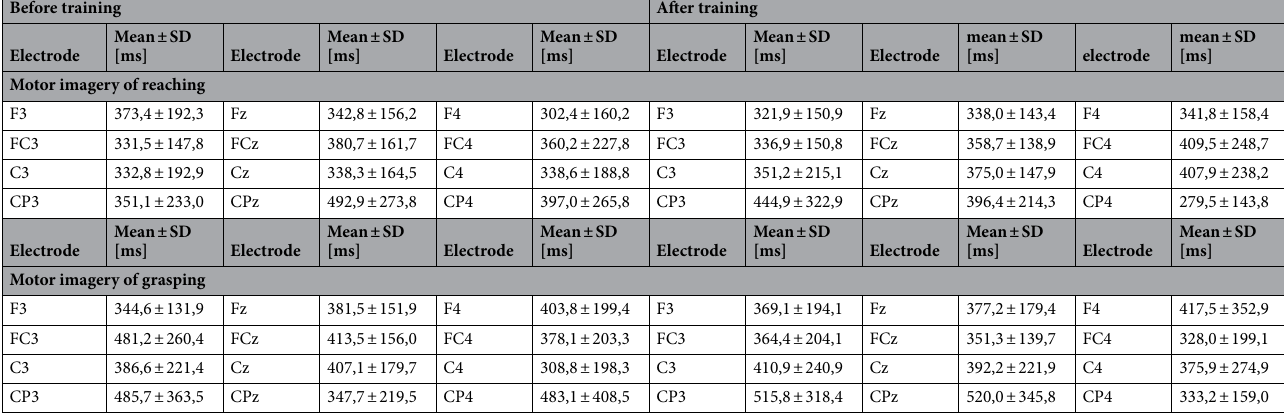
Table 4. Mean value with standard deviation of ERP latency [ms] for motor imagery of reaching and motor imagery of grasping before and after 4 weeks of motor imagery training. Notice that the spatial arrangement of the electrodes in the table corresponds to the International 10–10 System.